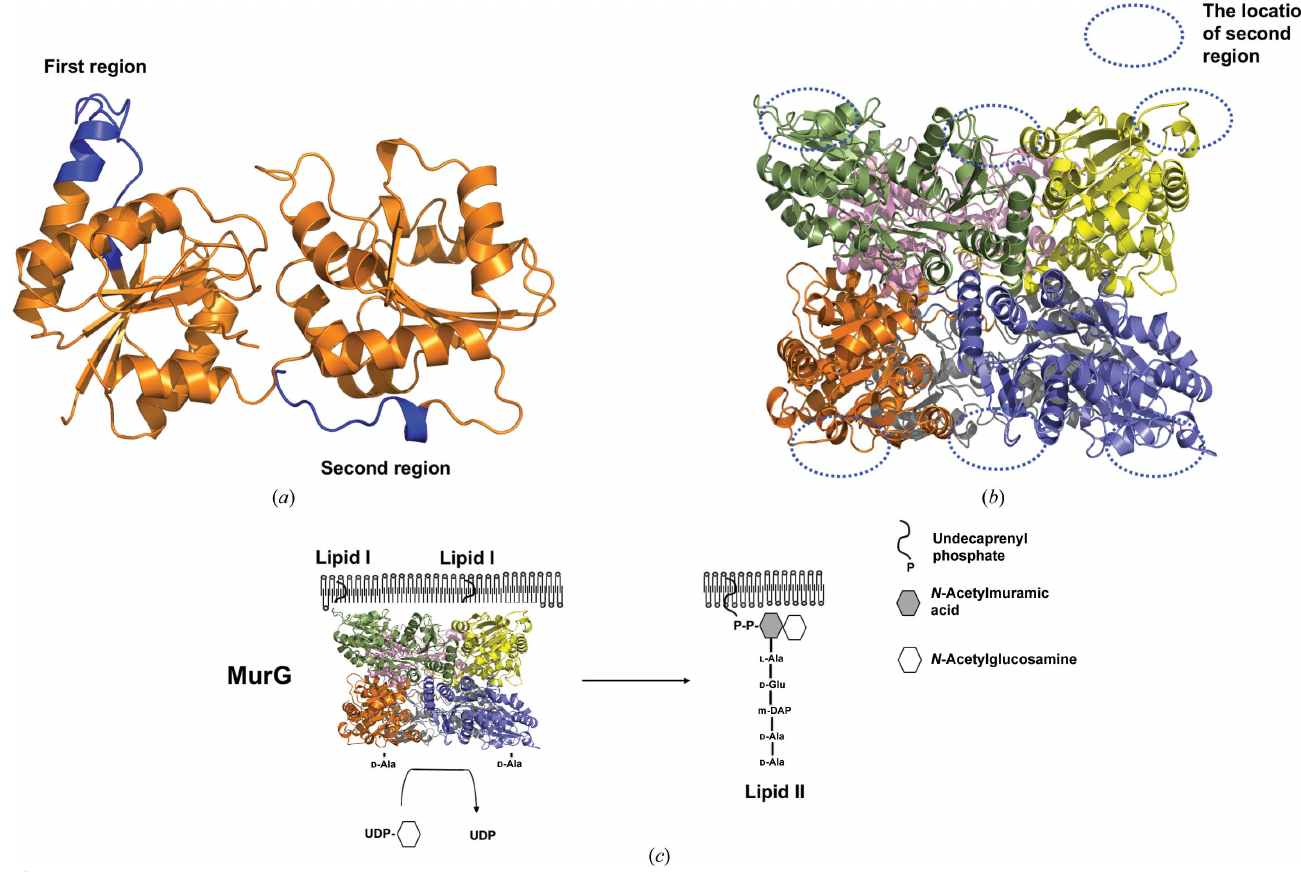
Figure 5 Proposed working model of hexameric MurG on the membrane. ( a ) Tentative membrane-docking regions on MurG. Membrane-anchoring regions were predicted by the MODA server. Two regions, colored blue, were analyzed as tentative membrane-docking regions. ( b ) The location of the second region, formed by a small helix connected by a loop, on each subunit of hexameric MurG. ( c ) Tentative working model of hexameric MurG on the